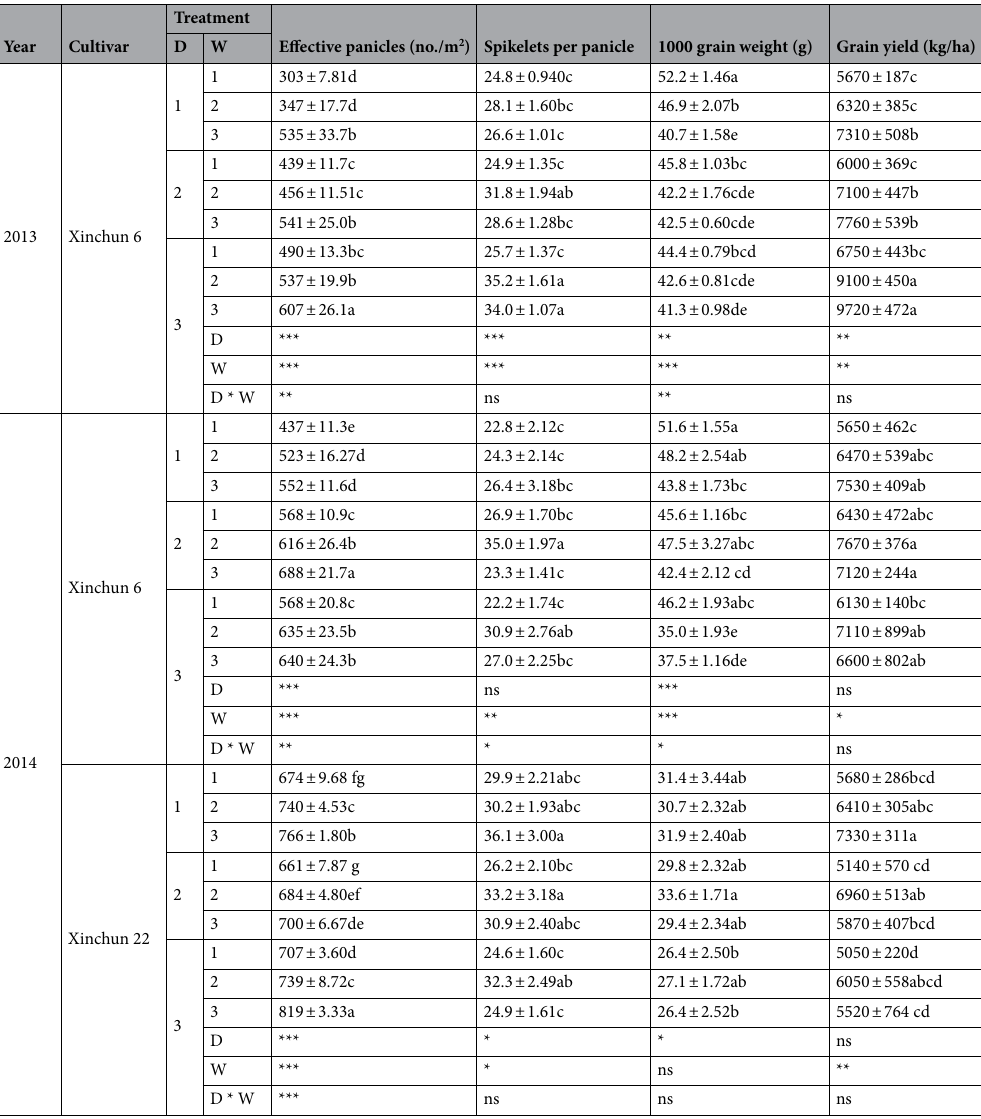
Table 4. Wheat grain yield and yield components as affected by drip irrigation frequency and amount. ns represents no significance at the 0.05 probability level. *Represents significance at the 0.05 probability level. **Represents significance at the 0.01 probability